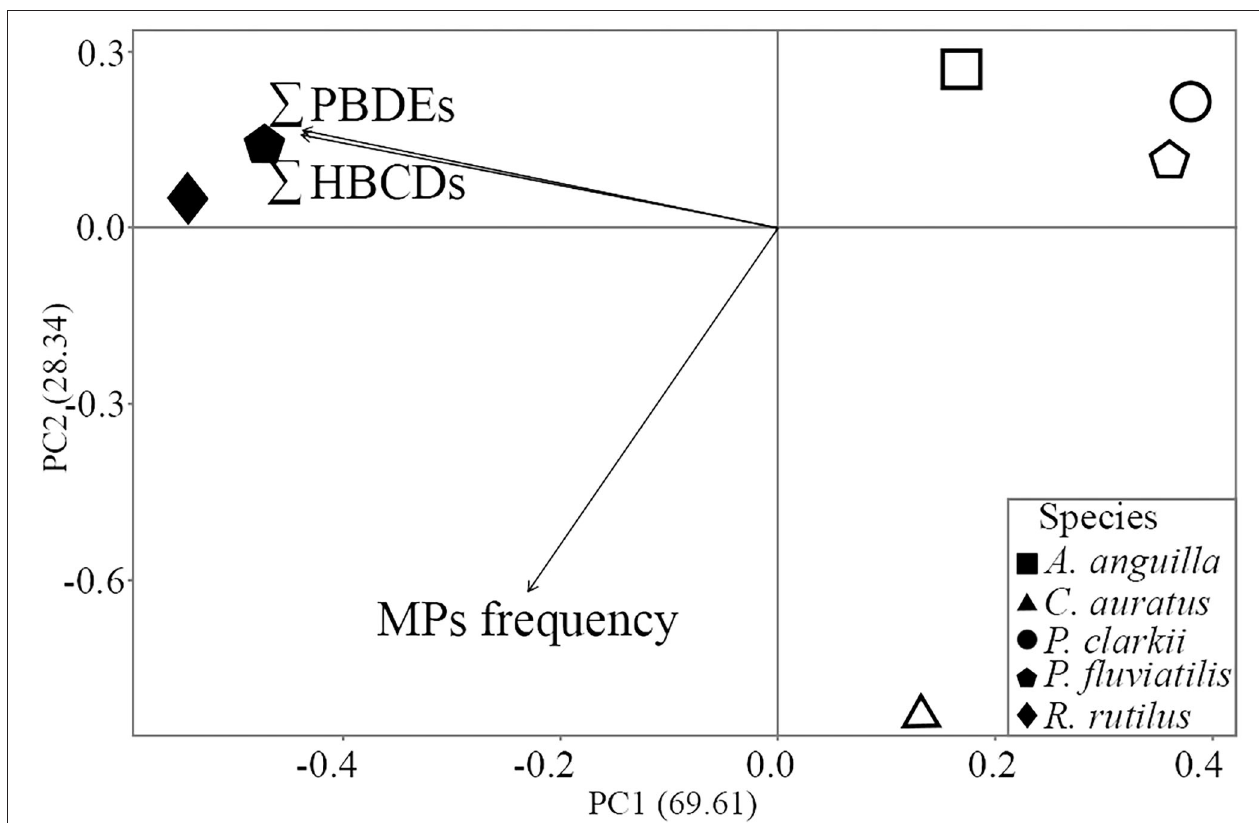
FIGURE 7 | Principal Component Analysis (PCA) ordination based on frequency of MPs ingestion, P 10 PBDEs and P 3 HBCDs; Piediluco Lake, filled shapes; Trasimeno Lake, empty shapes; contribution to the separation of each variable is represented by